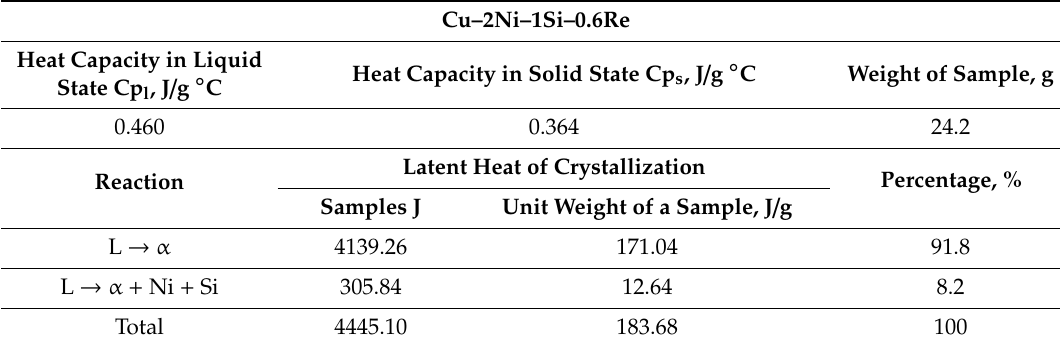
Table 4. Latent heat of crystallization produced by phases and its percentage in the total heat of crystallization of Cu–2Ni–1Si–0.6Re alloy.